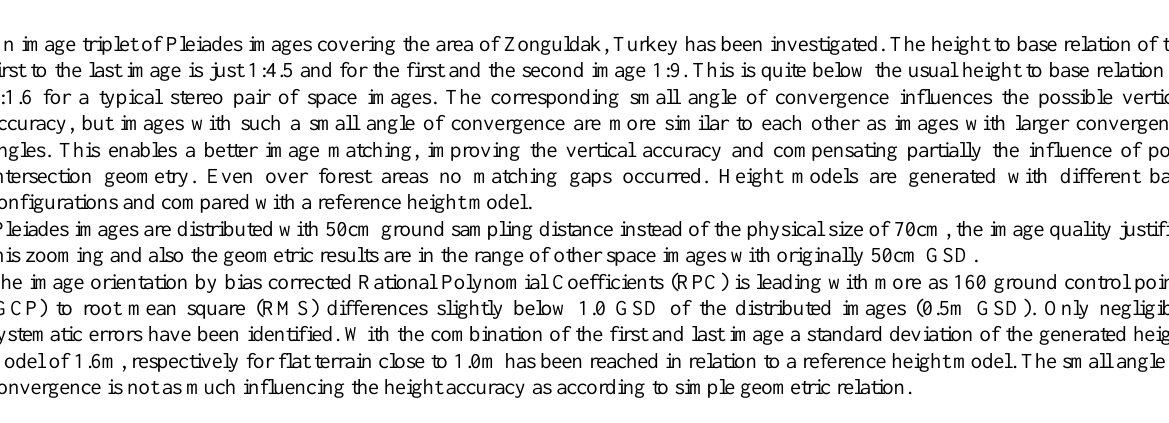
Figure 2. imaging